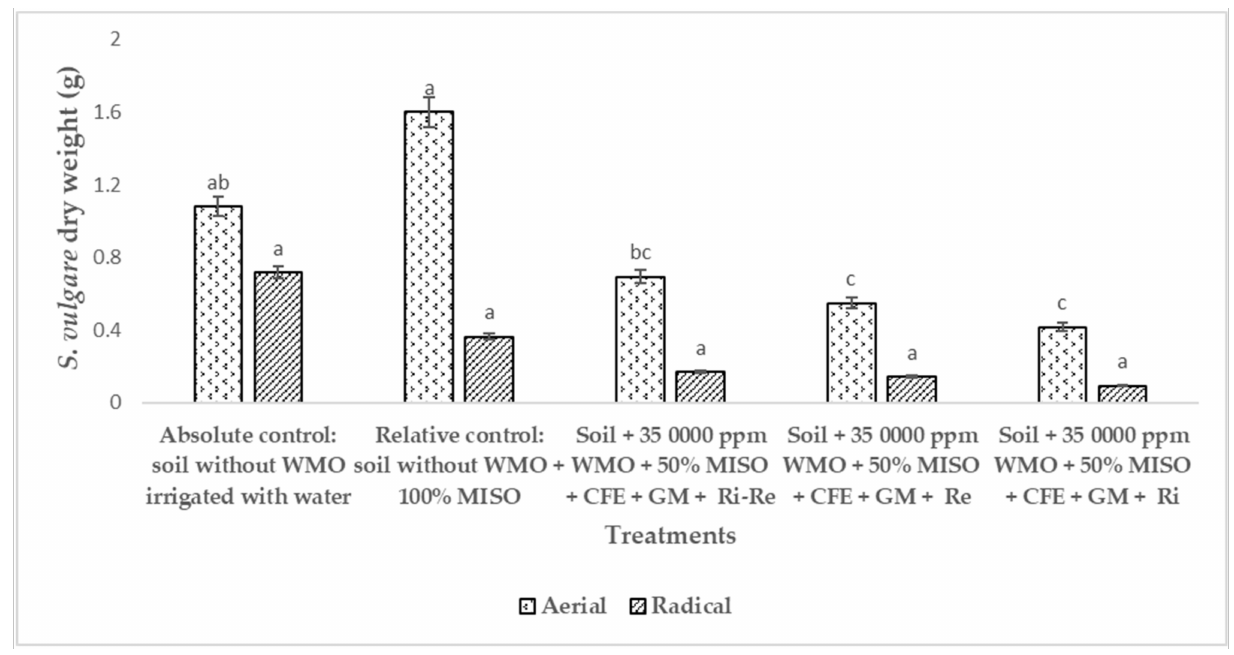
Figure 5. Dry aerial and radical weight of Sorghum vulgare with Rhizobium etli and/or Rhi- zophagus irregularis after 120 days of phytoremediation of polluted by waste motor oil. Notes: CFE = crude fungal extract, GM = green manure, MISO = mineral solution, Ri = Rhizophagus irregularis , Re = Rhizobium etli , WMO = waste motor oil. Different letters indicate statistical difference ANOVA- Tukey ( p < 0.05). Number of repetitions ( n ) =